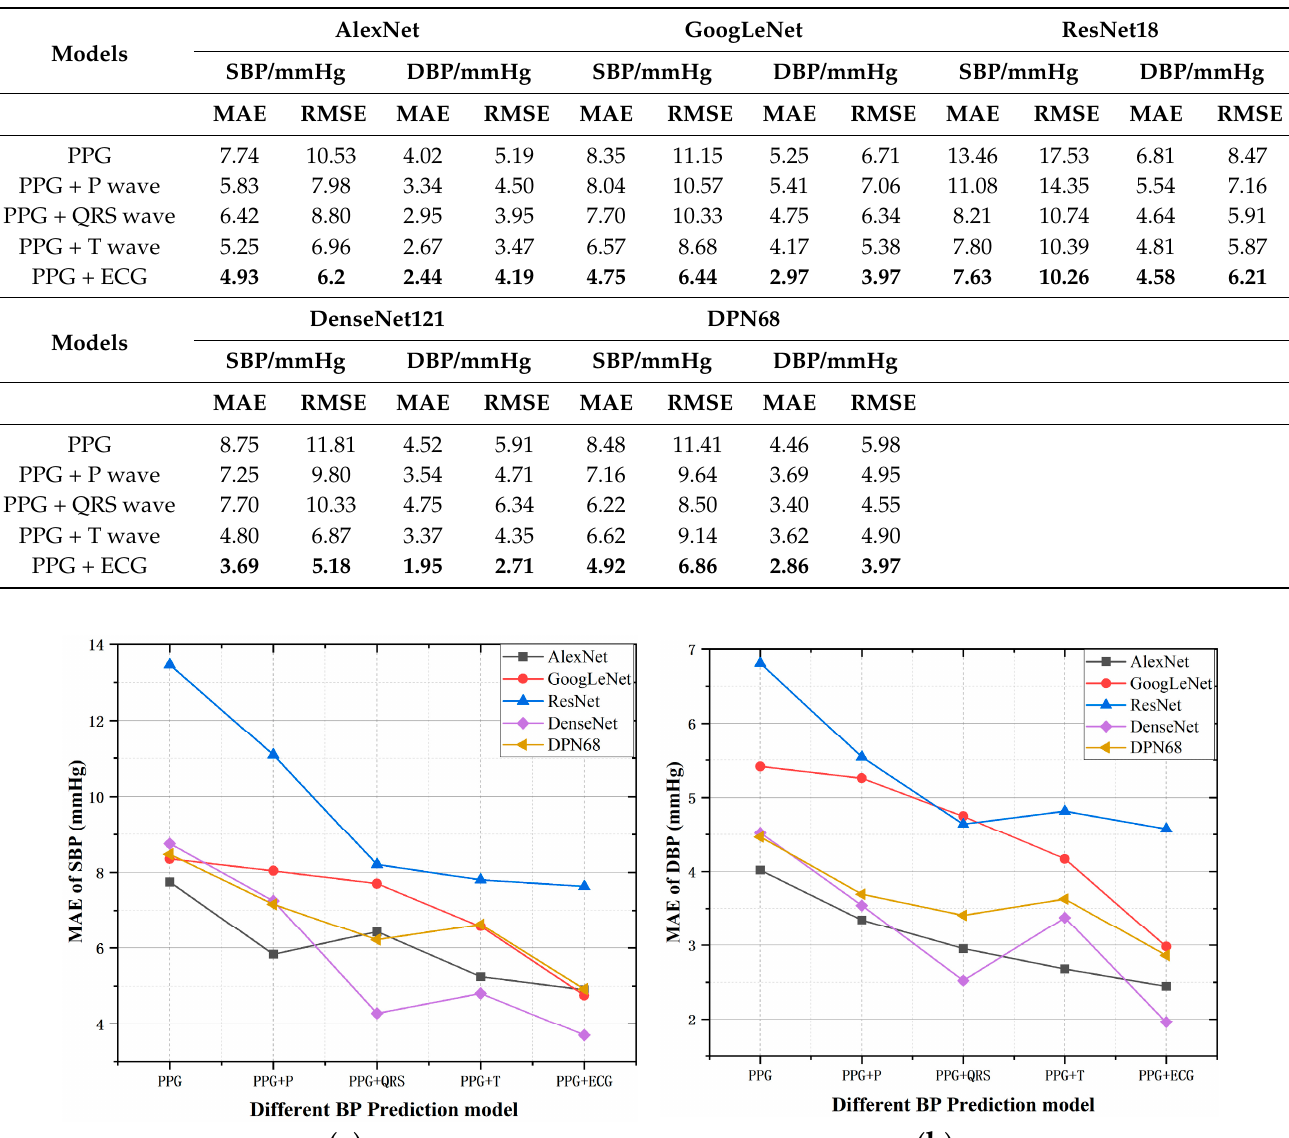
Table 1. MAE and RMSE of five models with different input signal combinations. Models